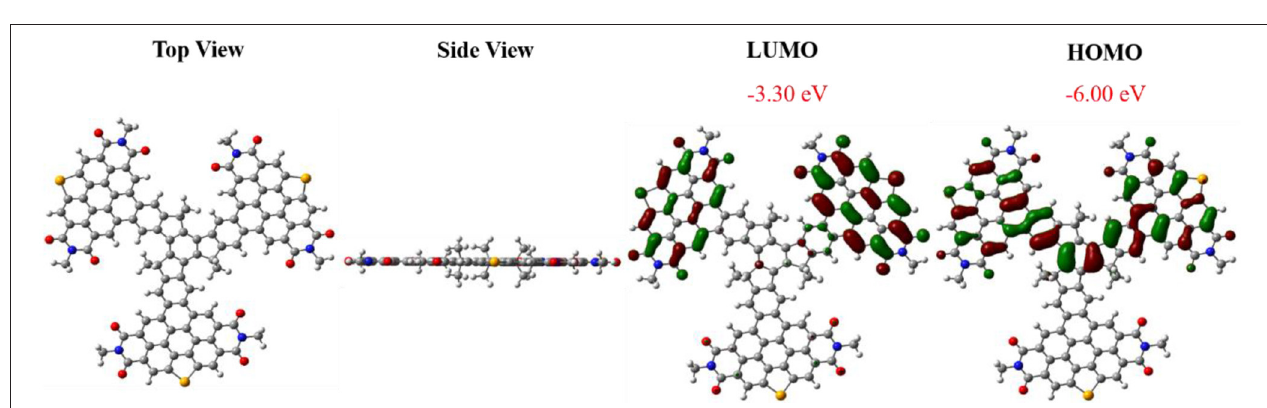
FIGURE 1 | Views of the optimized geometries of FTr-3PDI-Se, and the LUMO/HOMO electron distribution obtained using DFT calculations at the B3LYP/6-31G(d)